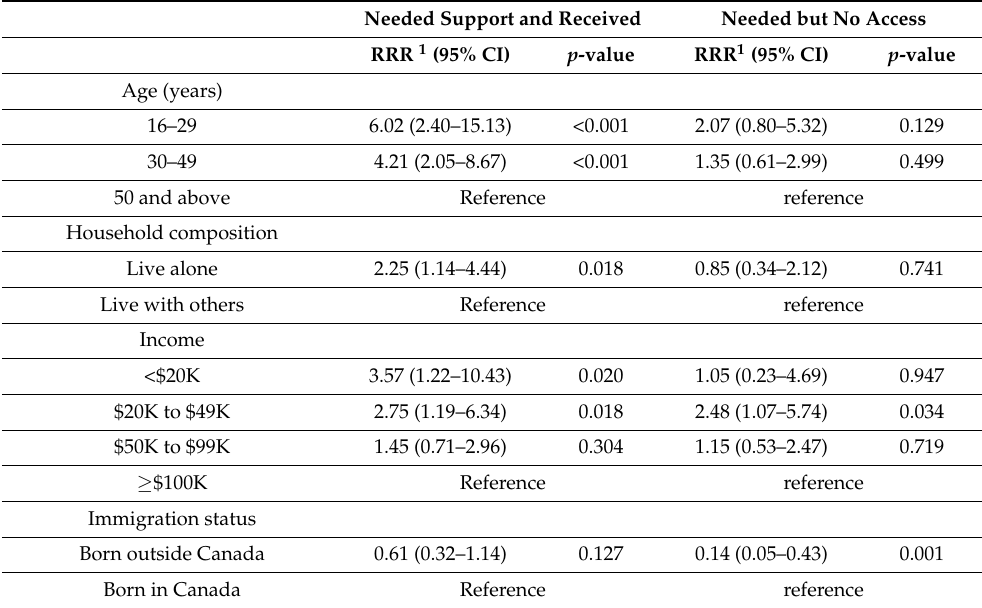
Table 4. Factors associated with self-reported mental health support seeking behavior (needed sup-